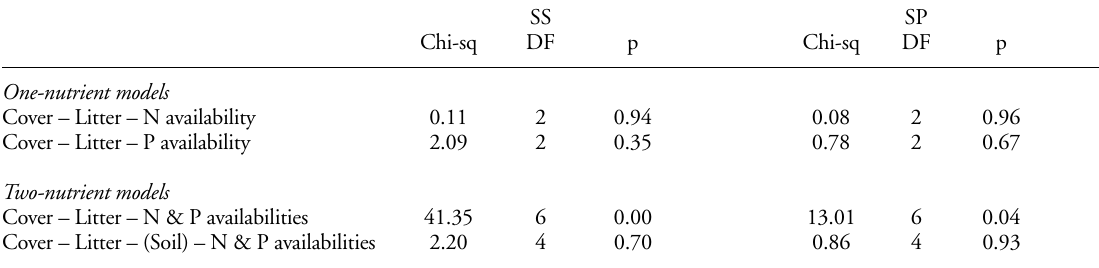
Table 3. D-sep test results of different causal models explaining the observed covariation between canopy density (“Cover”), litter accumulation (“Litter”), and nutrient (N and/or P) availability in the two studied sites (SS = Spanish site, SP = Portuguese site). The upper panel shows the results related to models including only one nutrient (N or P). The lower panel refers to models including both nutrients (N and P). These models consider either litter accumulation the immediate cause of their variation (upper line, correspond- ing to a model with independent errors) or assuming that litter influence on the availability of the two nutrients is mediated by an unmeasured, latent factor related to soil processes (lower line, corresponding to a model with correlated